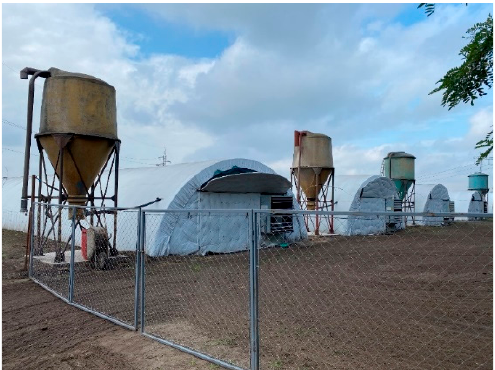
Figure 2. The commercial Hungarian duck fattening farm with foil tents (experimental site).